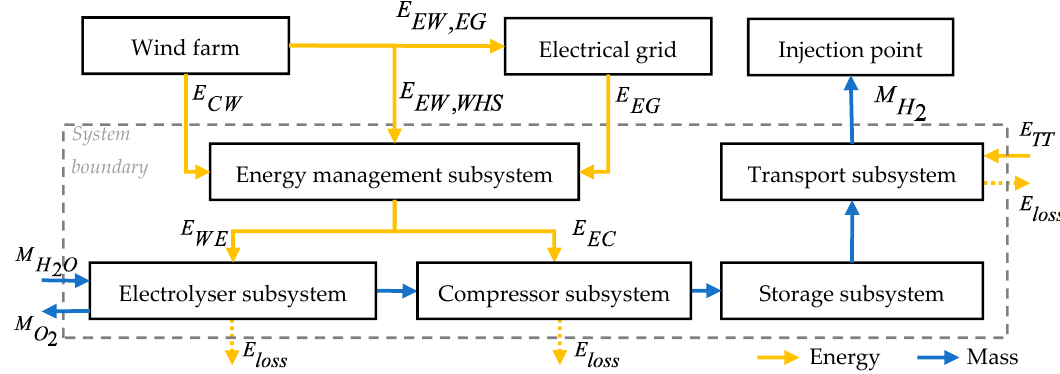
Figure 1. Block diagram of a wind-hydrogen system (WHS) which is located at each wind farm in Ireland.